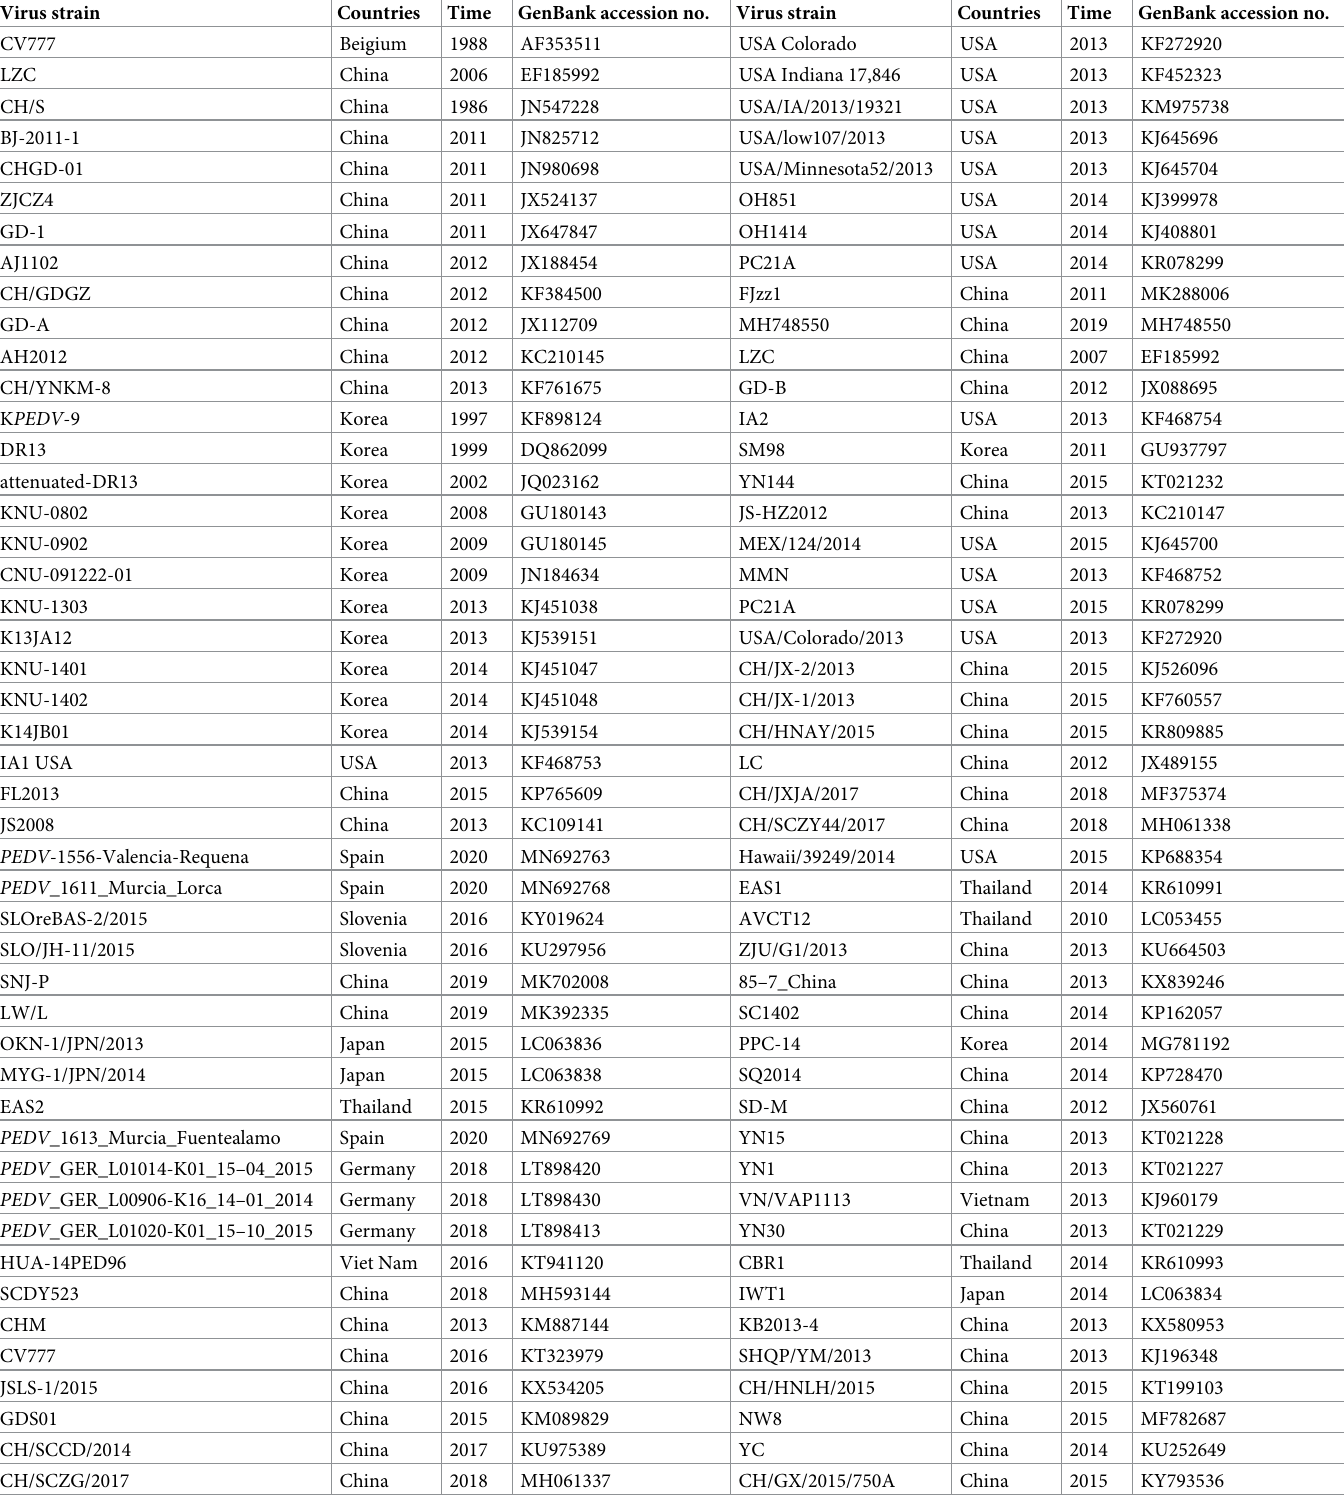
Table 3. PDEV reference strains described in this